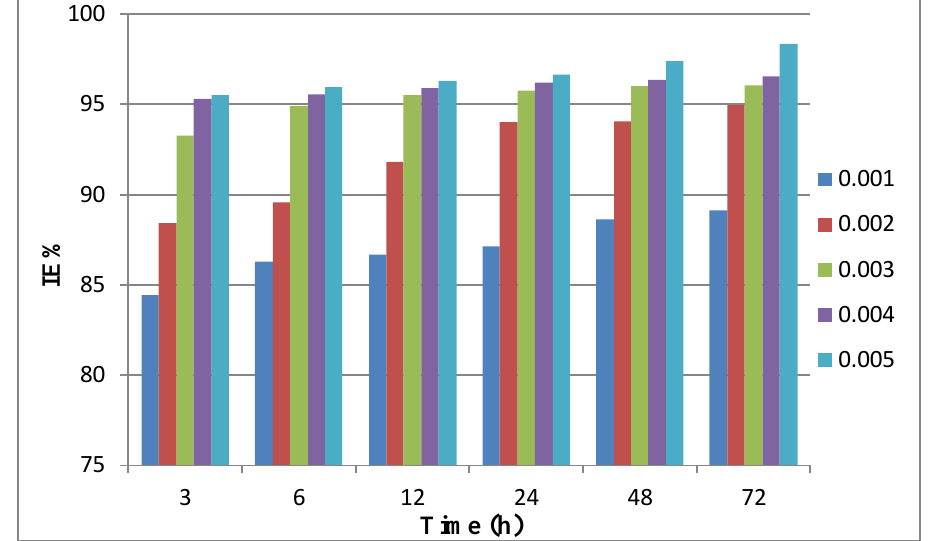
Figure 4: Corrosion rate for diverse immersion time at different concentrations of ABCP.